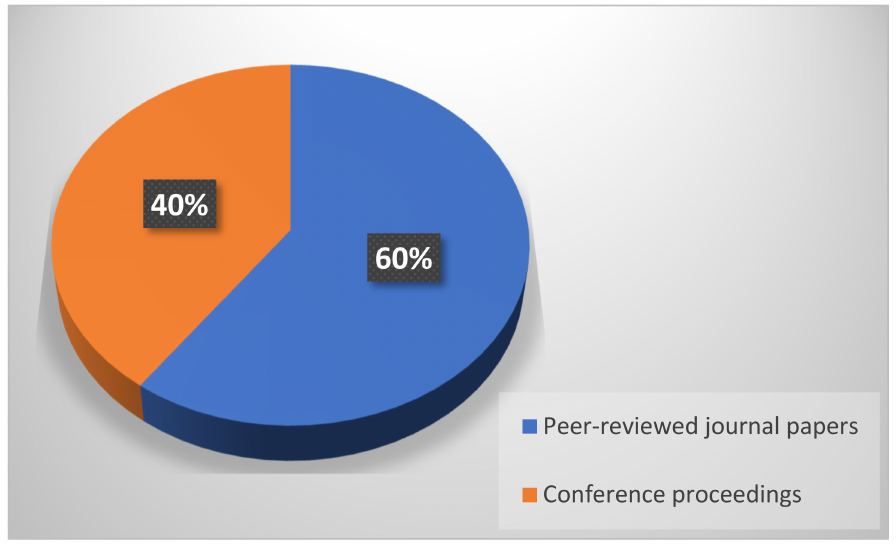
Figure 8. Project outcomes included 40 published papers related to the ESA–MOST Dragon-4 project research activities, 24 of which were peer-reviewed journal papers and 16 of which were international conference